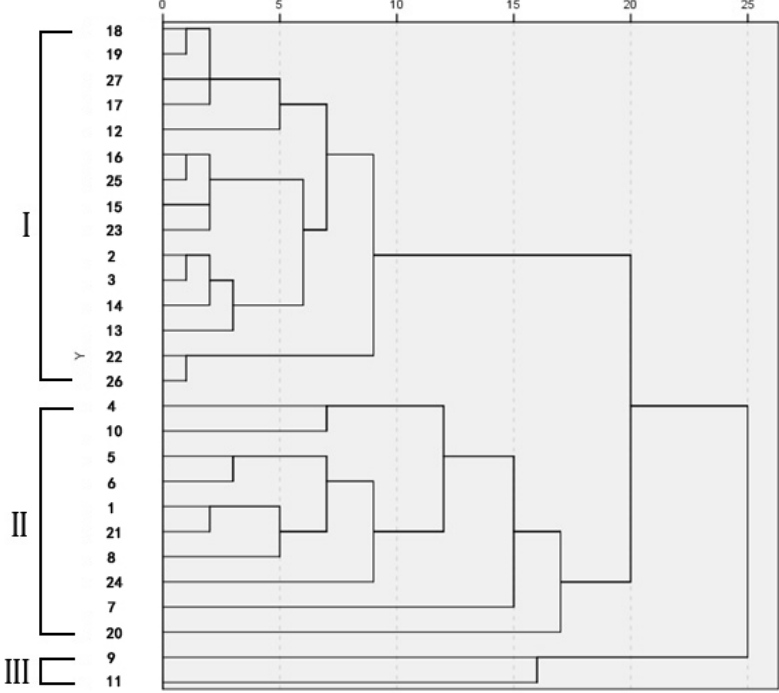
Table 2. Landscape spatial characteristics of the three types of morning points.